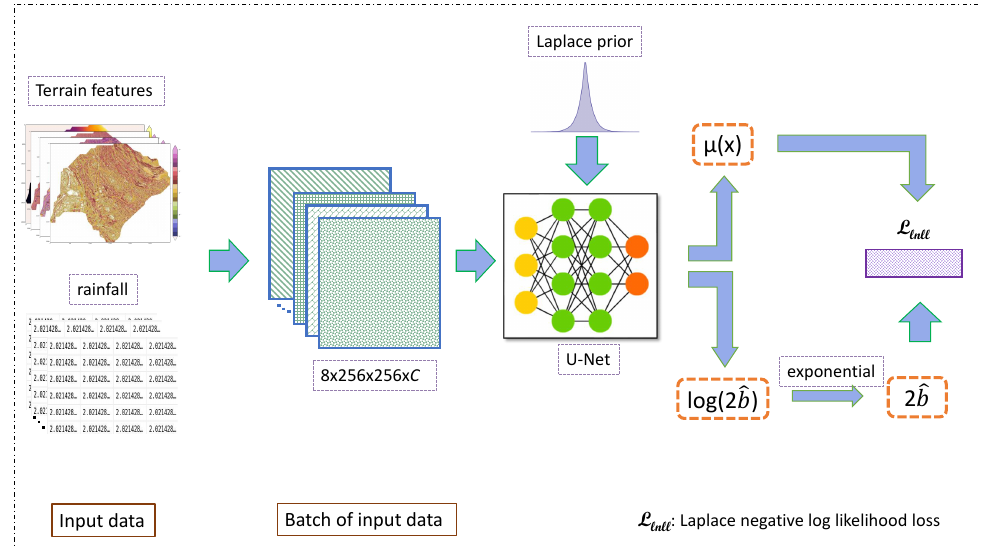
Figure 4. The illustration of our deep learning approach. Here, we show only one of the M models included in the ensemble. The model is trained to receive as an input the digital elevation model (DEM), terrain features and rainfall channels. The output consists of a pixel-wise maximum water depth estimation across the DEM and the scale parameter of the Laplacian distribution, through which we then compute the predictive